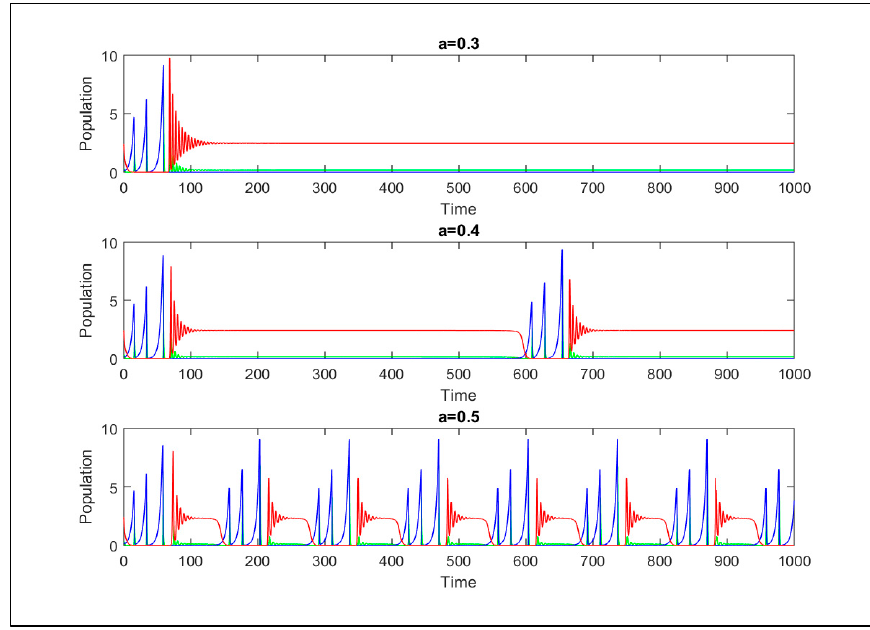
Figure 4. Time series solution at different values of consumption rate of common resource ‘ a ’.